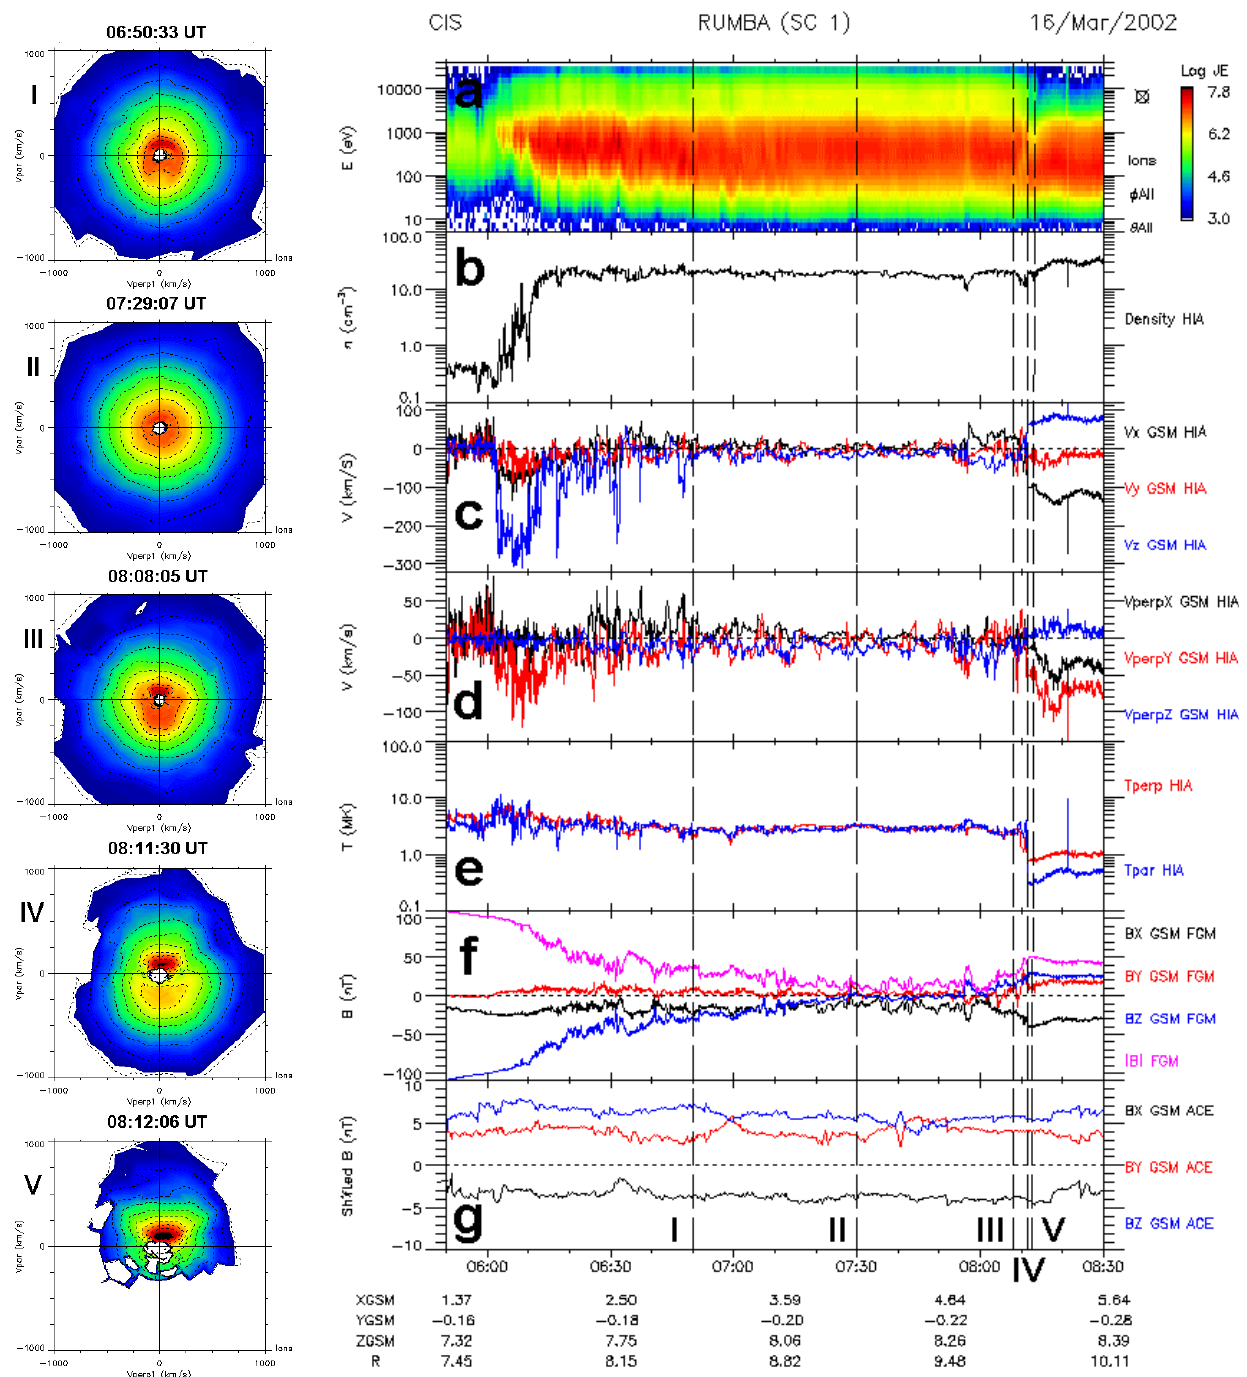
Fig. 2. This plate shows combined CIS, FGM and ACE IMF data. The first panel (a) shows the ion spectrogram from the CIS/HIA instrument. Panel (b) shows the density from HIA. The ion bulk velocity in displayed in panel (c) while the velocity perpendicular to the magnetic field (the convection velocity) is shown in panel (d) (both in GSM coordinates). Panel (e) presents the parallel and perpendicular (assuming gyrotropy) temperatures in Mega Kelvin (MK). Panel (f) displays the FGM magnetic field components in GSM and its modulus. Panel (g) shows the IMF monitored by the ACE spacecraft. The data have been time shifted according to correlation with FGM data in the adjacent magnetosheath. Below the panel composer, the position of the spacecraft in GSM coordinates is displayed for five different times. On the left side of the plate are displayed 5 distribution functions of interest. They are taken at five different times and are in the form of cuts through the ( V // , V ⊥ ) plane. These are displayed in the spacecraft frame so that, for example, the bulk flow observed in the magnetosheath ( V ) contrasts with the isotropic and stagnant nature of the SEC